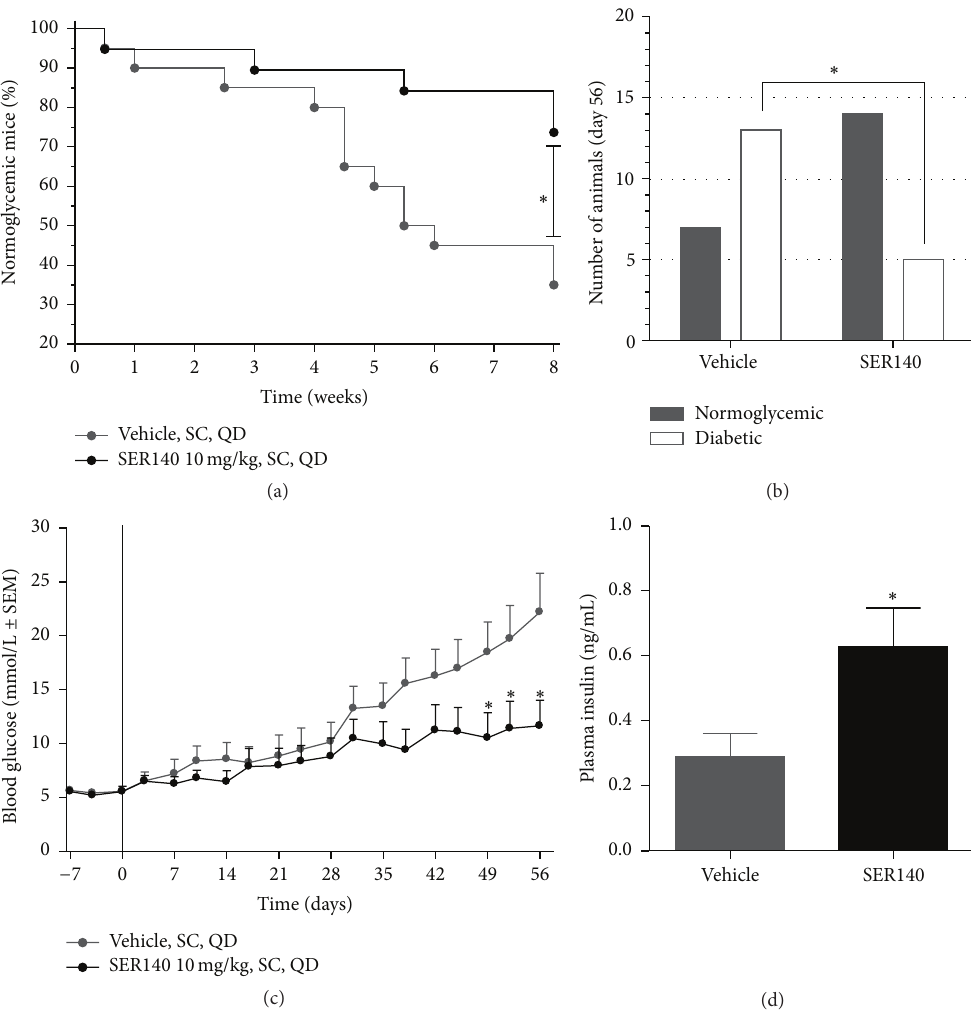
Figure 2: Development of diabetes in NOD mice. (a) Proportion of mice (percentile) having normal glucose levels defined as nonfasting BG below 10mmol/L from day 0 to day 56. (b) Number of normoglycemic versus diabetic animals at day 56. Statistical significance was obtained between the variables ( 𝑝 = 0.025 , Fisher’s exact test) with a higher incidence of diabetes in the vehicle group ((a) and (b)). (c) Morning fed BG during a time period from day − 7 to day 56. (d) Plasma insulin levels at day 56. Unpaired 𝑡 -test ∗ 𝑝 < 0.05 . ((c) and (d)) Data are presented as mean ± SEM ( 𝑛 = 18 –20/group). (c) Two-way ANOVA w/Bonferroni post hoc test. (d) Unpaired 𝑡 -test. ((c) and (d)) ∗ 𝑝 < 0.05 compared to